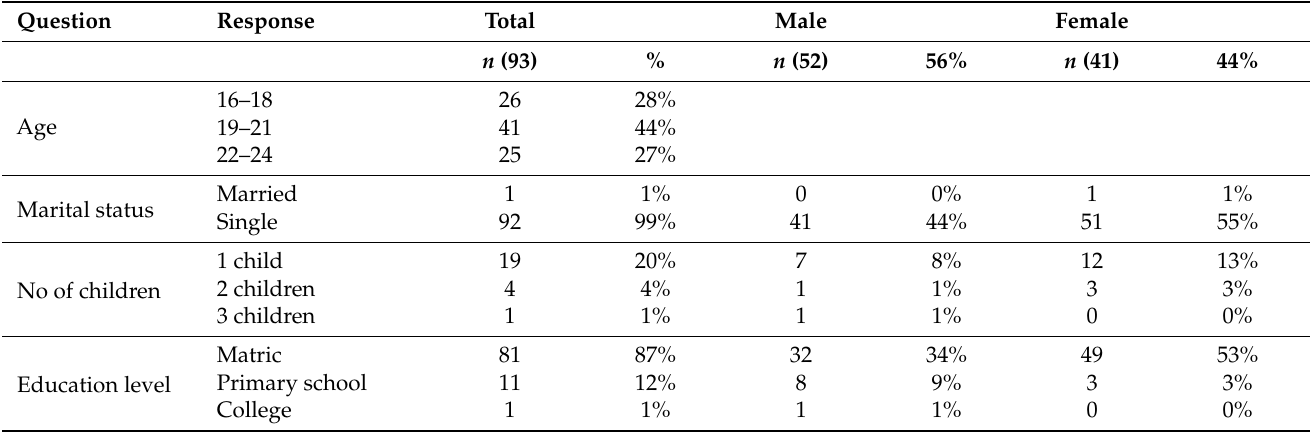
Table 2. Showing the demographic characteristics of the study participants.